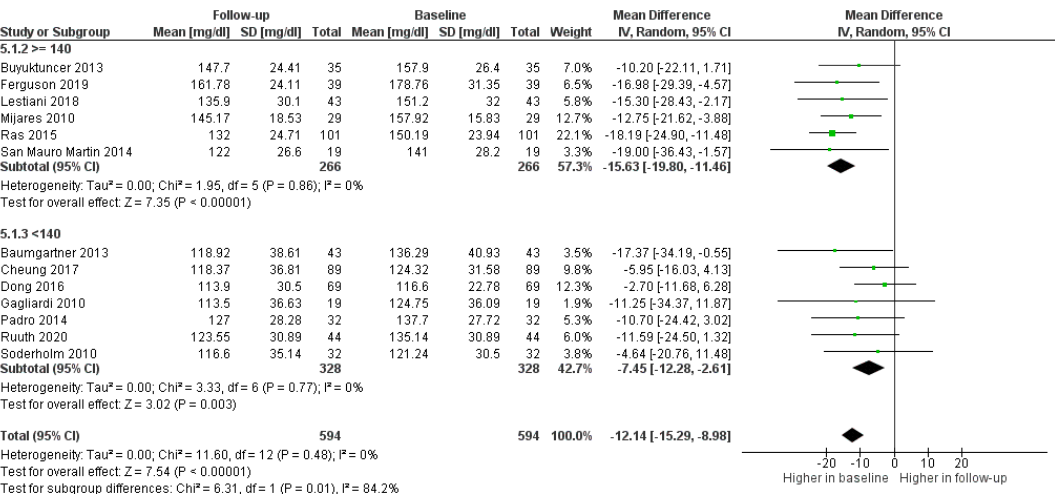
Figure 4. Forest plot comparing different dosages of PSs among participants in the treatment groups.